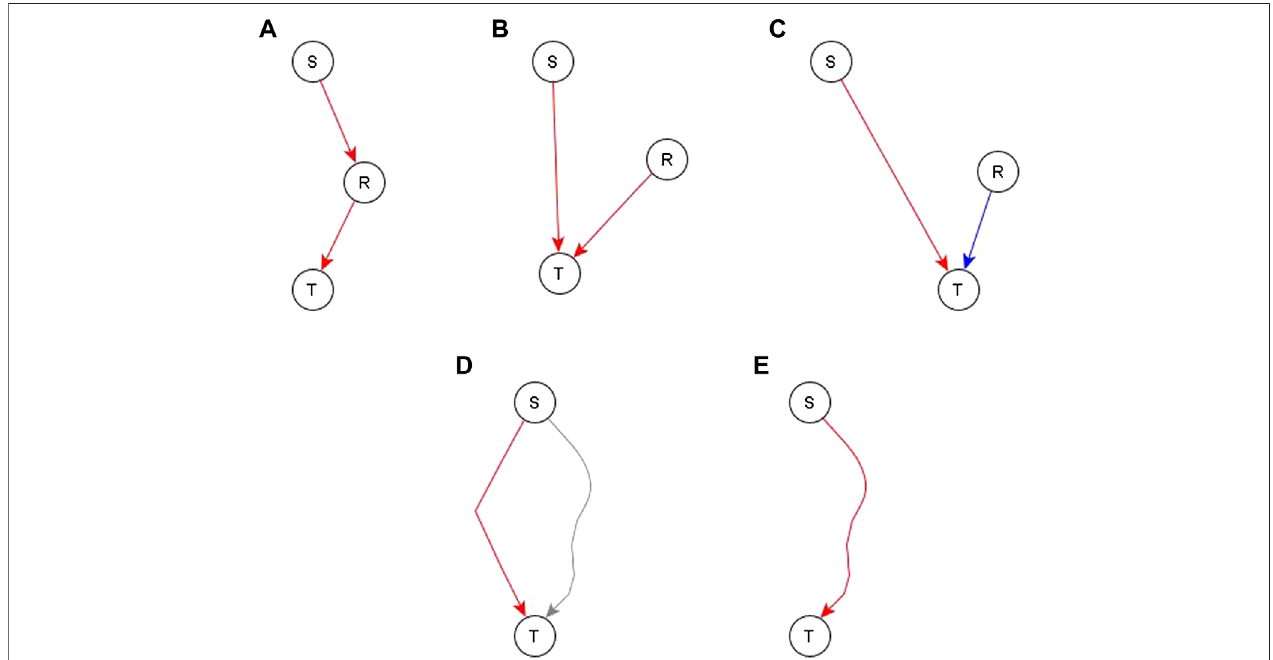
FIGURE 4 | Different ways to incorporate an indirect relationship from a regulator S to a target node T when S is suf fi cient for T. Panels (A – C) describe the case when there is no existing path or subgraph from the regulator (S) to the target node (T) and panels D and E describe the case when there is an existing path/subgraph from S to T. (A) . An existing regulator of T, namely R, is suf fi cient for T. If there is also biological support for a pathway or causal relationship from S to R, we complete a suf fi cient path from S to T by adding a suf fi cient edge from S to R. (B) . An existing regulator R of T is suf fi cient for T but there is no evidence to support a causal relationshipfromStoR.Inthiscase,weconstructanindependentsuf fi cientedgefromStoT. (C) .AnexistingregulatorRisnecessaryforT.Wecannotbecon fi dentthat Rdoesnotin fl uenceS,thus theco-pointingtheoremcannotbeapplied.SincethecausallogicrelationshipbetweenSandTis “ suf fi cient ” ,weconstructanindependent suf fi cient edge from S to T. (D) . A path/subgraph exists from S to T, but its logic implication is not the same as the desired suf fi cient causal logic — this path is marked in gray. In this case, we add an independent suf fi cient edge from S to T to satisfy the “ suf fi cient ” logic. (E) A suf fi cient path/subgraph exists from S to T. In this case, the expected causal logic relationship already exists and hence we do not add any